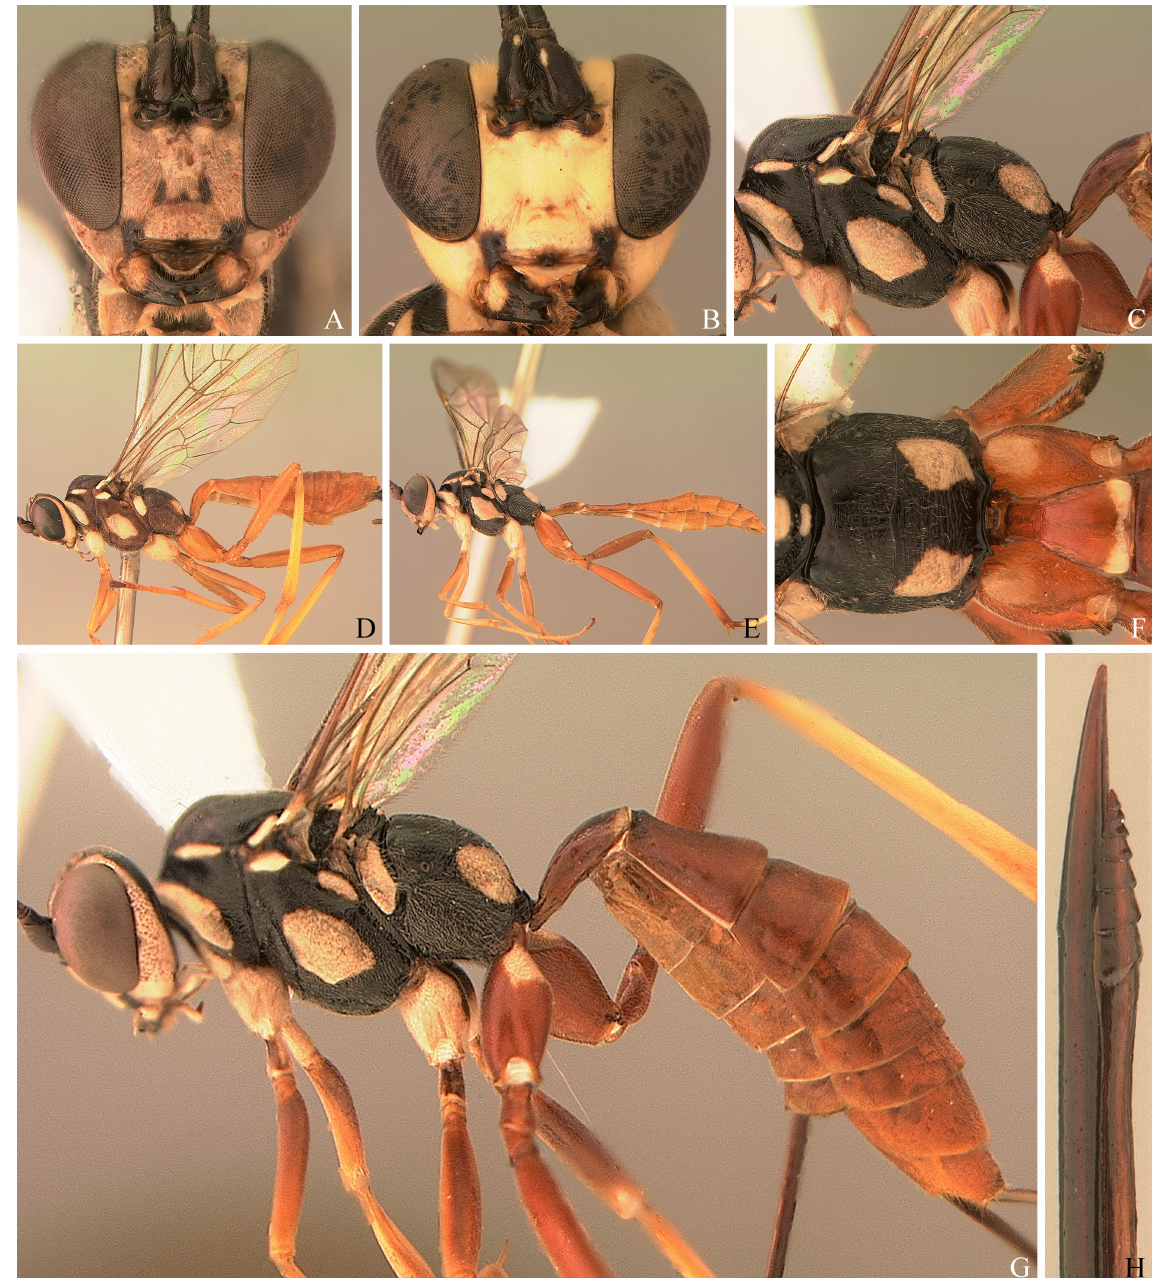
Fig. 15. Distictus tibialis (Brullé, 1846). A–B . Head, frontal view (A: UFES; B: CNCI). C . Mesosoma, left side (UFES). D . ♀, habitus (DZUP). E . ♂, habitus (UFES45305). F . Propodeum + coxae + first tergite, dorsal view (UFES51229). G . ♀, habitus (UFES). H . Apex of ovipositor, left side